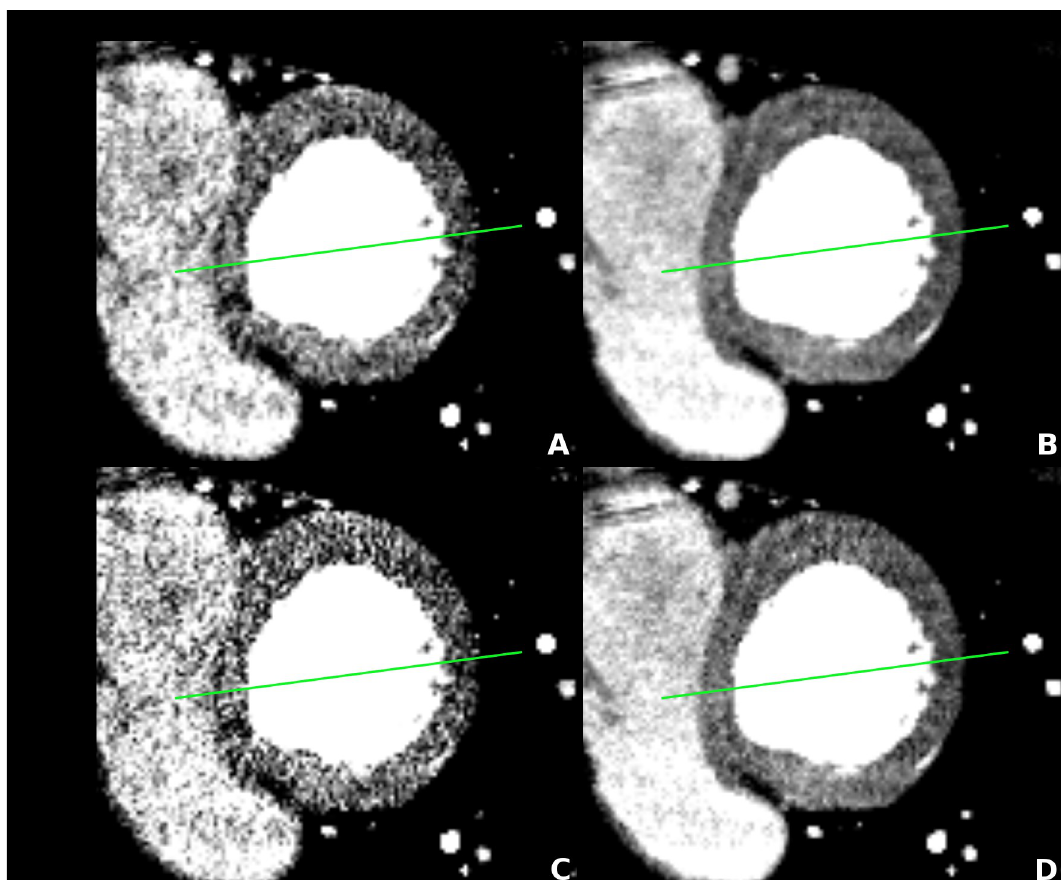
Fig 2. Contour sharpness measurement. Measurement of the contour sharpness was performed by placing a straight line above the heart connecting the myocardium of the left and the right ventricle, taking great care to avoid the inclusion of any perfusion defects or blooming artefacts into the measurement. Thus, we included 4 different representative localisations to cover the myocardium localised between: 1) the right ventricle and the septal myocardium, 2) the septal myocardium and left ventricle, 3) the left ventricle and lateral left ventricular myocardium and 4) the lateral left ventricular myocardium and surrounding epicardial tissue. To ensure exactly the same localisation for the different reconstructions and temporal averaging levels, the geometric coordinates of the measuring line were used for the different combinations: AIDR 3D without temporal averaging (A), AIDR 3D with temporal averaging (B), FBP without temporal averaging (C) and FBP with temporal averaging (D).